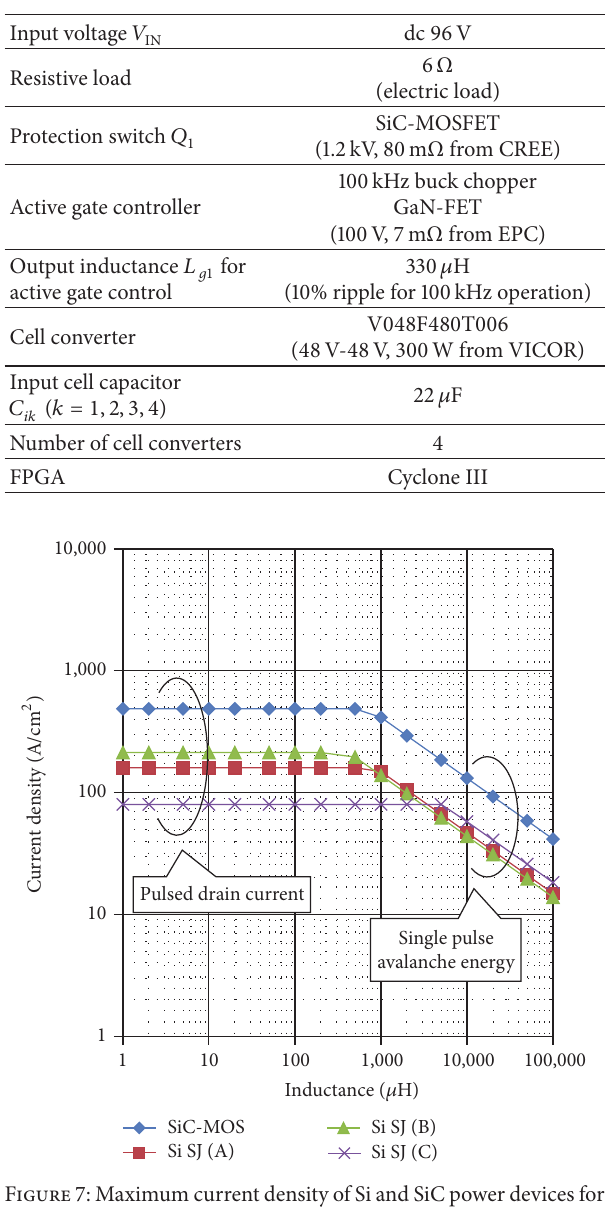
Table 2: Parameters for fabricating four cell ISOP converters with protection switch.